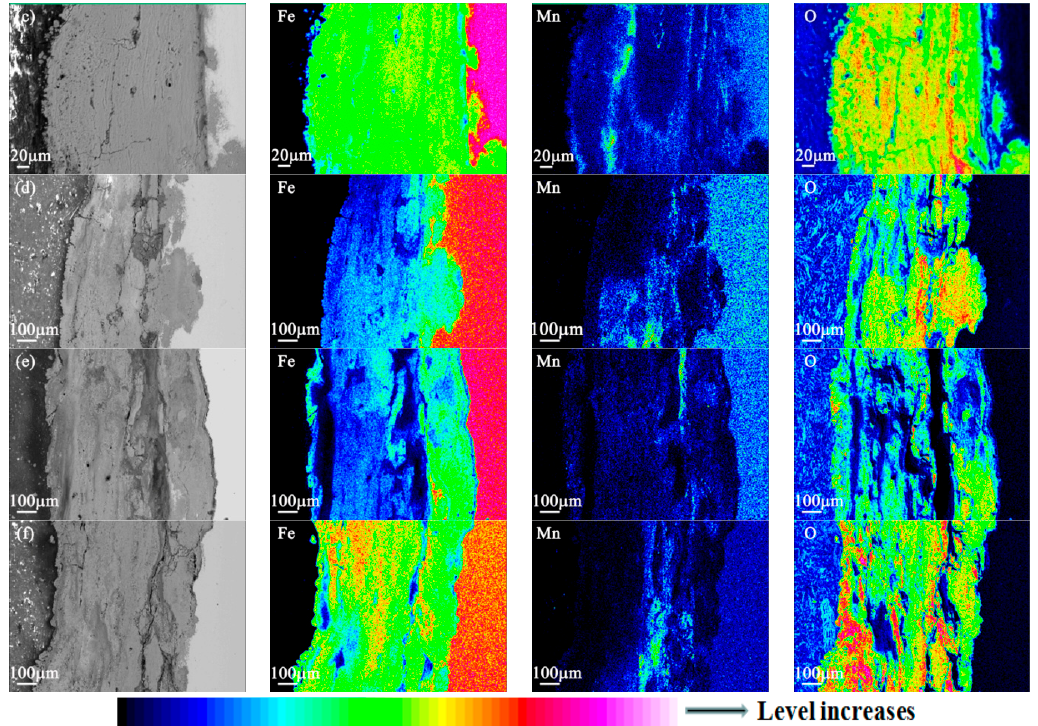
Figure 5. The main elemental distribution of the corrosion products formed in the tested medium-Mn steel after different immersion durations: ( a ) 24 h; ( b ) 72 h; ( c ) 168 h; ( d ) 288 h; ( e ) 432 h; and ( f ) 600 h.